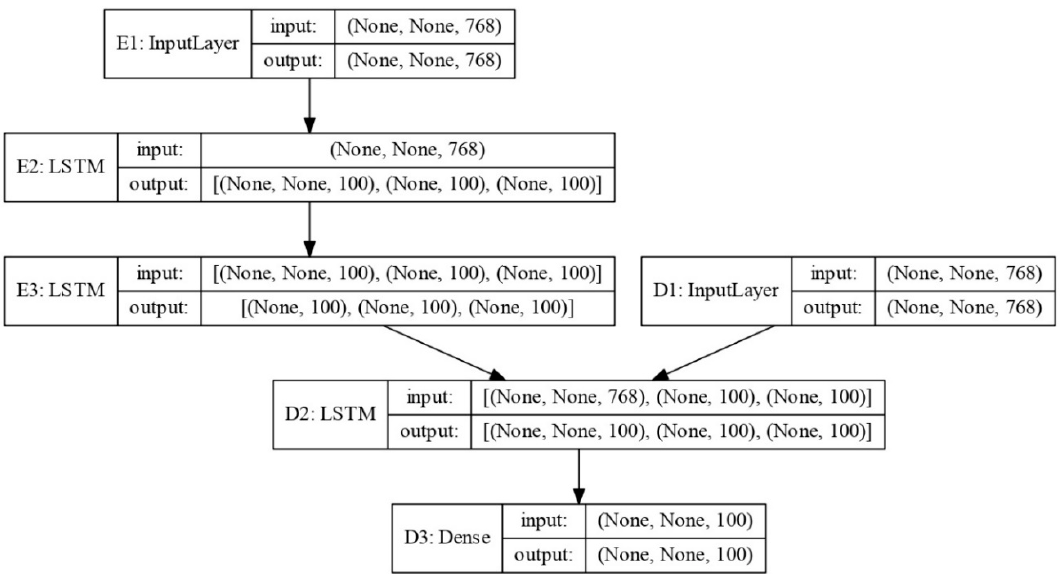
Figure 3. Two-layer stacked LSTM encoder and one-layer LSTM decoder (abbreviated as LSTM2 encoder and LSTM decoder). E1, E2, E3 represent the encoder; D1, D2, D3 represent the decoder.